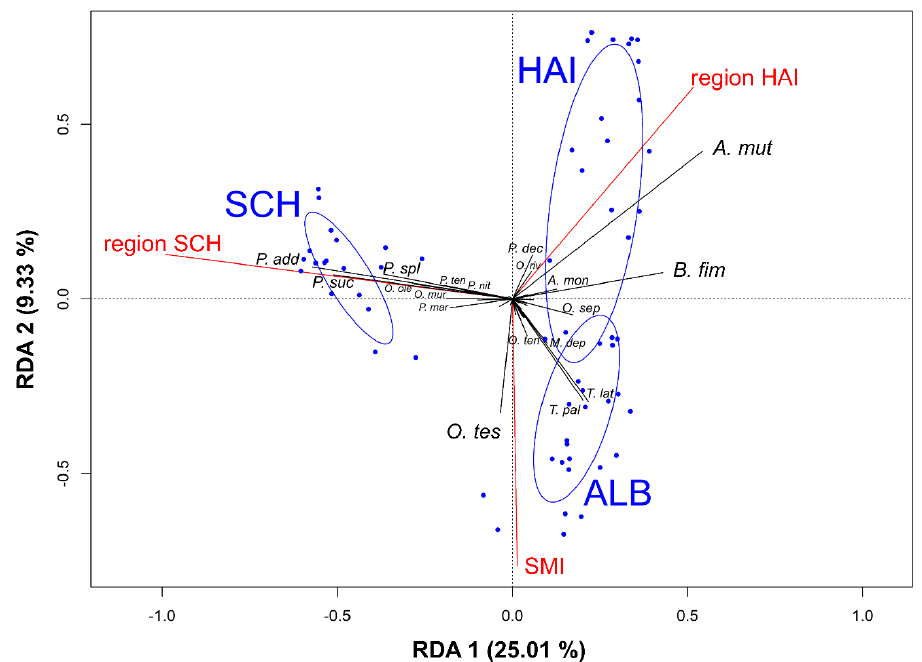
Figure 2. Correlation triplot of the first two axes obtained from the redundancy analysis (RDA) showing the relationship between rove beetle communities on carrion and important environmental parameters (sites as blue points and blue ellipses for region groups, species scores as black lines and labels and explanatory variables as red lines and labels). Only significant explanatory variables are shown. To provide better visualization, arrowheads for vectors were not included, and only 19 important species regarding their importance from a total of 80 species were plotted (see Table S2 for species abbreviation). ALB = Schwäbische Alb, HAI = Hainich-Dün, SCH = Schorfheide-Chorin, SMI = silvicultural management intensity index; A. mut = A. mutator , B. fim = B. fimetarius , O. tes = O. tessellatus , see Table S2 for all species abbreviations.